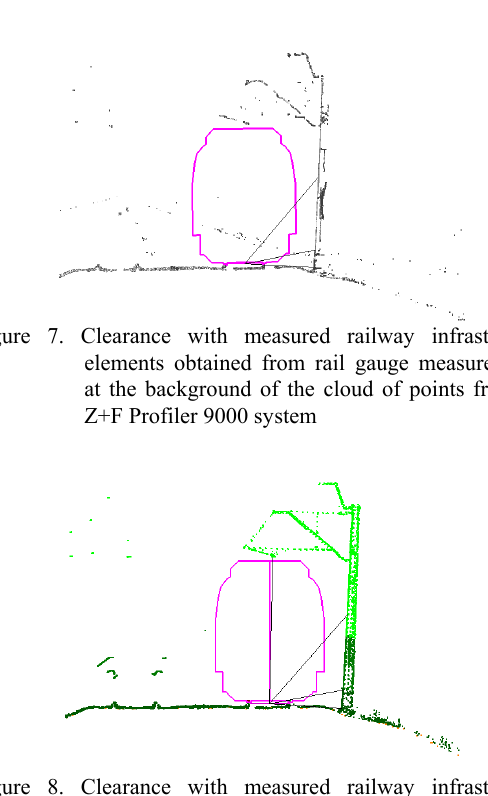
Figure 8. Clearance with measured railway infrastructure elements obtained from rail gauge measurements, at the background of the cloud of points originating from the Riegl VMX - 250 system